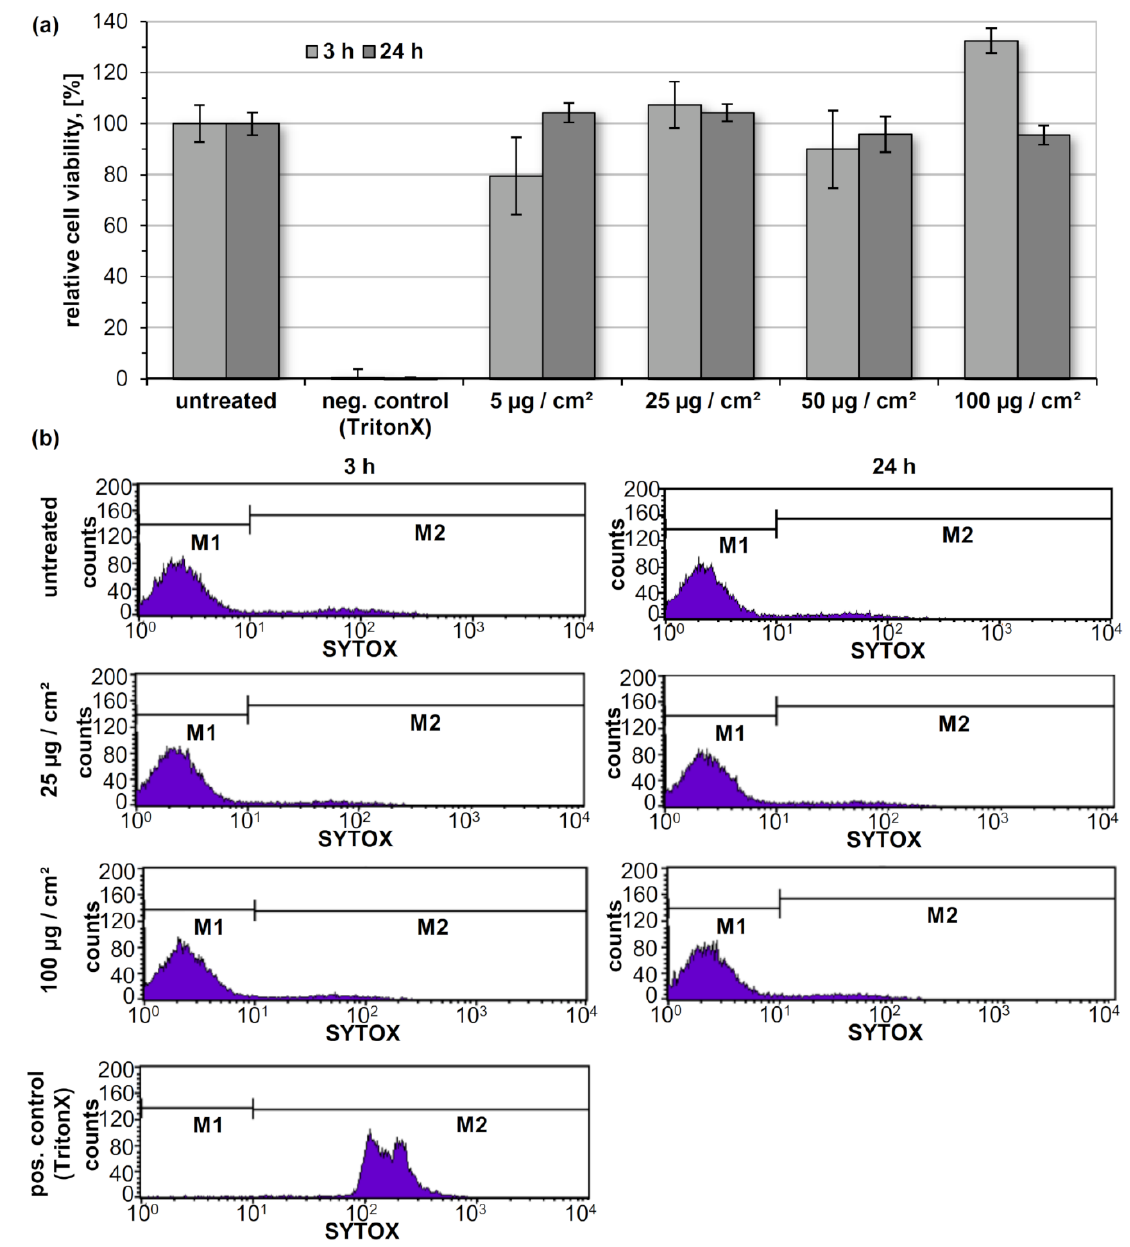
Figure 5. Results of cell viability assay ( a ) and flow cytometry assisted quantification of dead cells ( b ) using the hypopha- ryngeal carcinoma FaDu cell line after incubation with TritonX-100 (negative control in cell viability assay, positive control in flow cytometry assay) and with different amounts of dye functionalized xylan phenyl carbonate nanoparticles (XPC- NP).